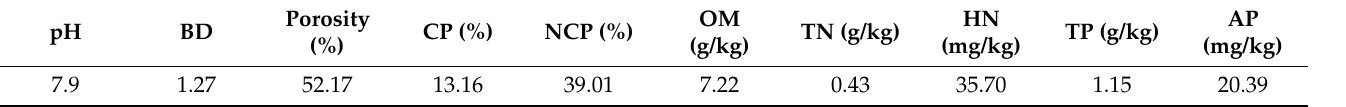
Table 2. Physicochemical properties of